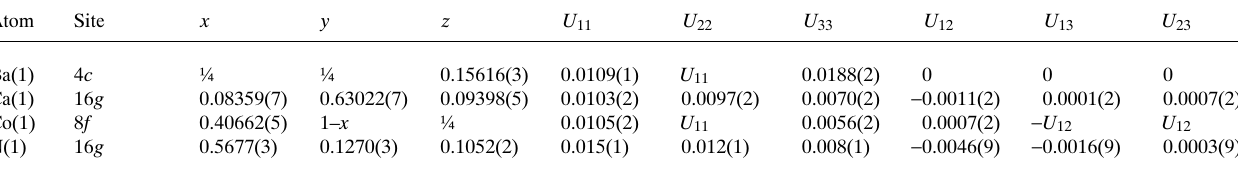
Table 2. Atomic coordinates and displacement parameters (in Å 2 )